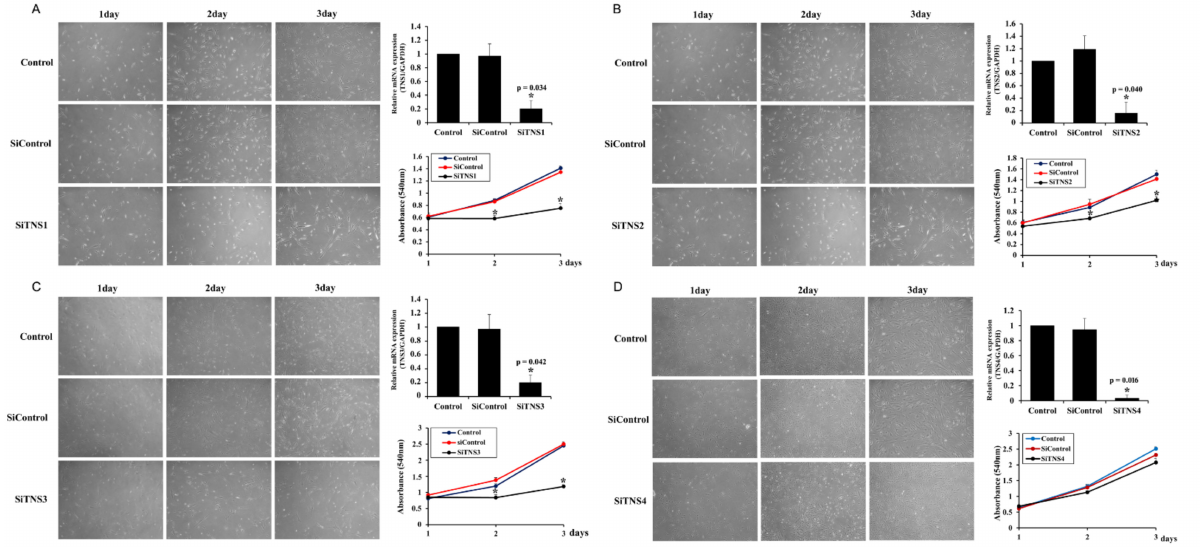
Figure 1. Tensin family regulates the proliferation of tonsil mesenchymal stem cells. Photomicro- graphs after siRNA TNS1 (siTNS1) ( A ), siTNS2 ( B ), and siTNS3 ( C ) transfection showed a significant reduction in cell numbers on days 2 and 3. However, no morphological changes were observed in transfected cells compared to those in the control. ( D ) Photomicrographs after TNS4 suppression showed no difference in cell number compared to that in the control. * p < 0.05, compared to the control. n = 4. Columns and error bars represent mean ± standard deviation.